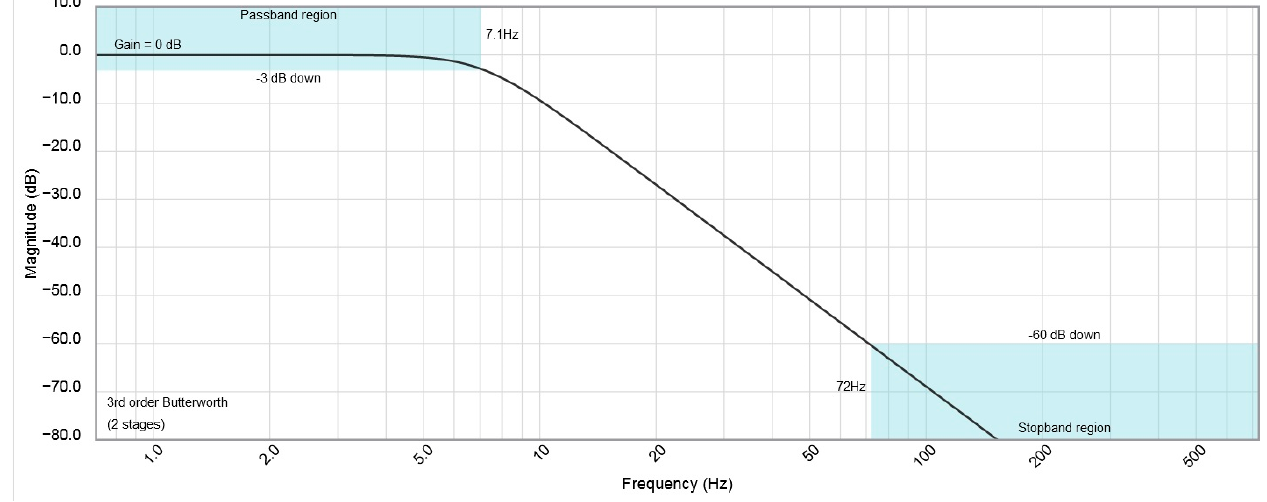
Figure 18. Simulation results of low-pass filter amplitude characteristics.